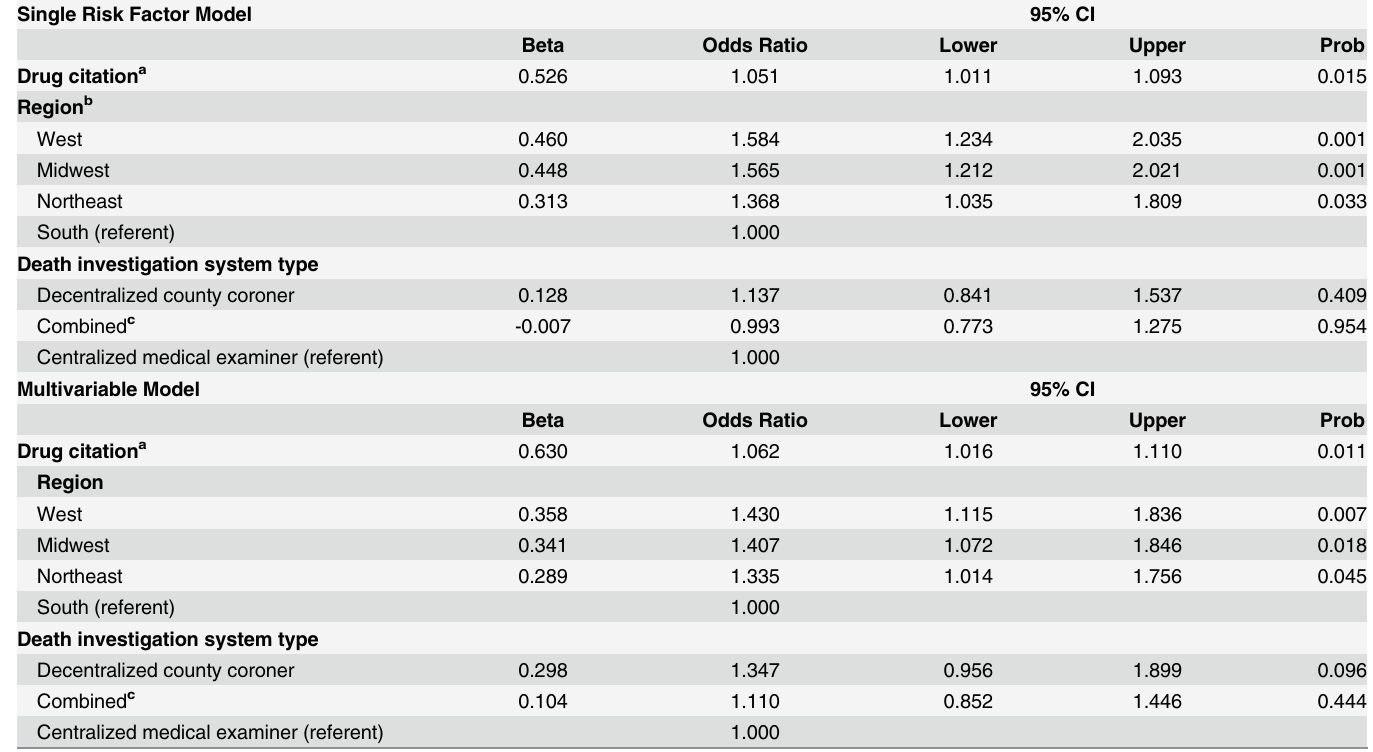
Table 2. Predicting the odds of a nonhomicide drug-intoxication death being classified as suicide versus accident or undetermined